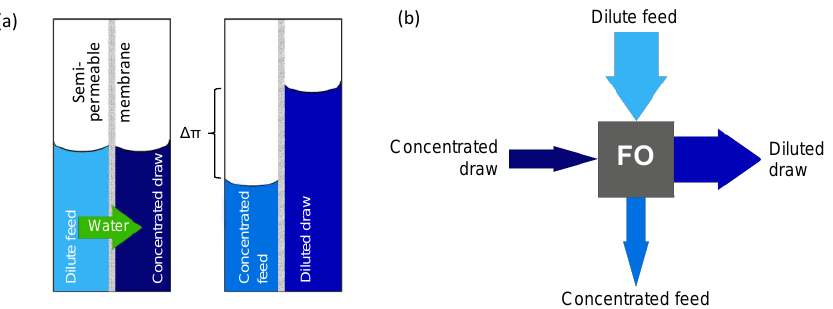
Figure 1. ( a ) Principle of FO using the osmotic pressure difference between two solutions to concen- trate a dilute feed solution; ( b ) FO process.